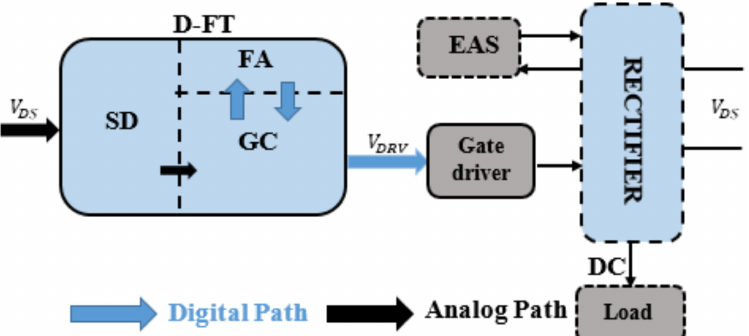
Figure 42. The schematic diagram for the direct frequency tracing “Reprinted from [49]”.